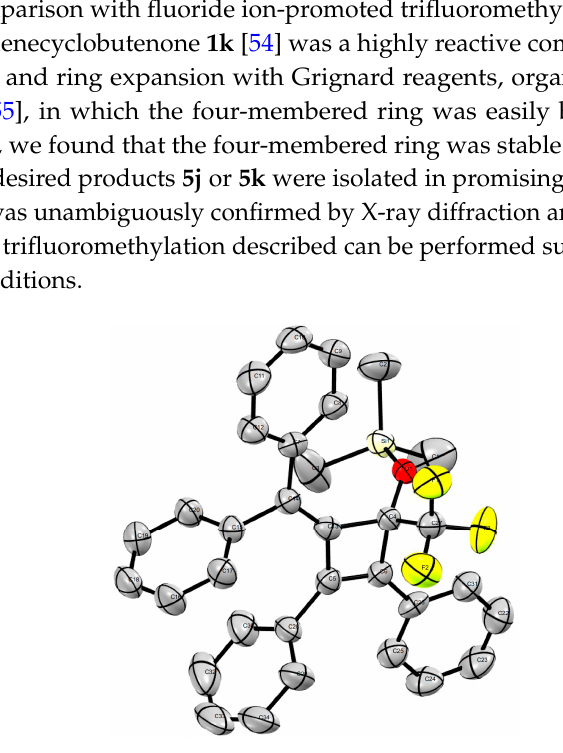
Figure 1. Crystal structure of 5k (CCDC 1487785).